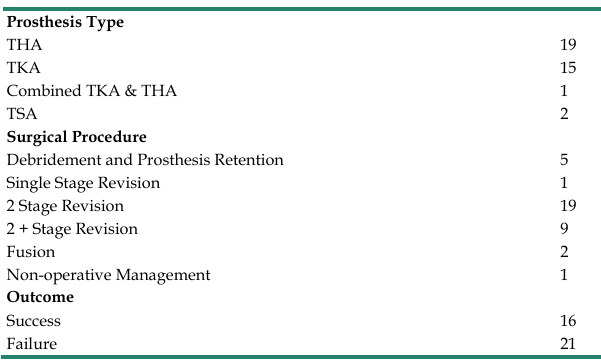
Table 3. Success Rate by Surgical Procedure and Culture Results. Surgical Procedure Number of Debridement and Prosthesis